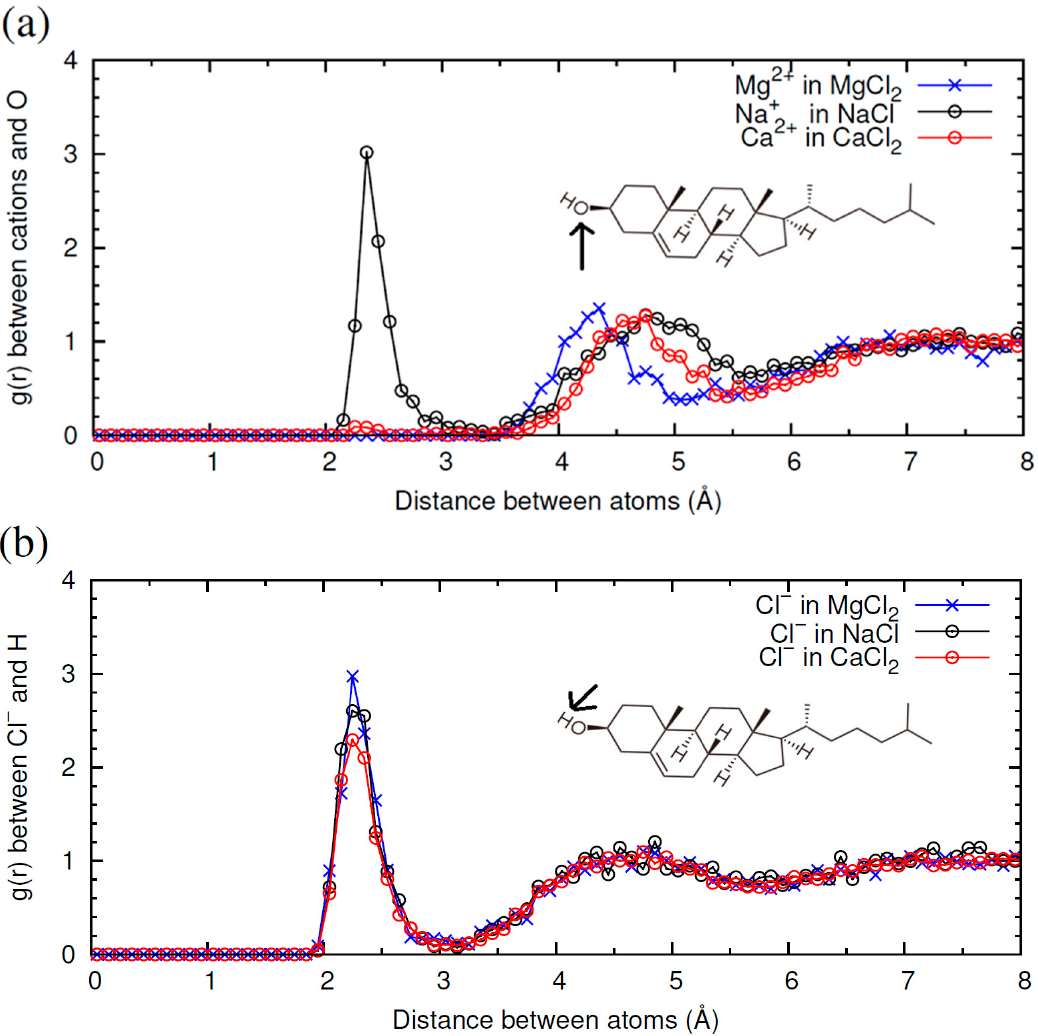
Figure 6. Radial distribution functions g ( r ) between ions from NaCl, CaCl 2 or MgCl 2 and CHOL headgroup obtained in three different MD simulations ( T = 298 K). In the presence of NaCl (black open circles), CaCl 2 (red open circles) or MgCl 2 (blue crosses). ( a ) g ( r ) between different cations and oxygen atom in -OH headgroup of CHOL: Na + from NaCl (black open circles), Ca 2+ from CaCl 2 (red open circles) or Mg 2+ from MgCl 2 (blue crosses); ( b ) g ( r ) between Cl − from different electrolyte (NaCl, black open circles, CaCl 2 red open circles, MgCl 2 blue crosses) and H atom in -OH headgroup of CHOL.